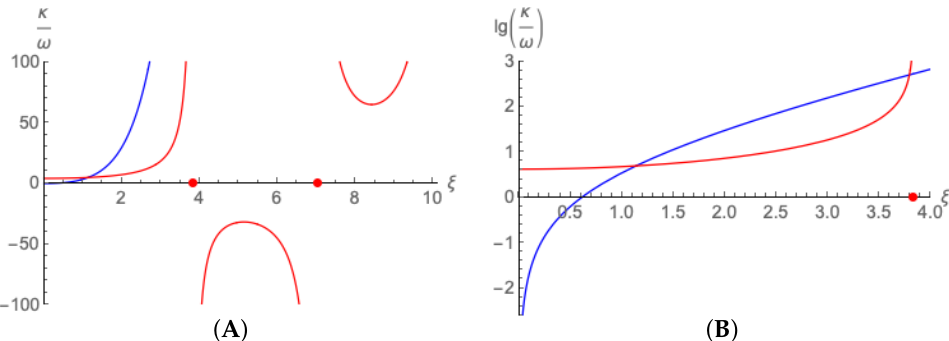
Figure 3. Model of Localized Vortices. Left pane l ( A ): Both axes are in linear scale. Right panel ( B ): Vertical axis is in log-scale. Both panels ( A,B ): A structure with three vortices forms only when √ κ / ω = ( 2 π /3 )( ξ / Z 1 ( ξ )) , where ξ = 3 ( l / R ) , l is the radius of a circumscribed circle, R = ( | α | β ) − 1/2 | ω / Ω ) | , α is the parameter characterizing the “rapidity” of increase in temperature with distance from the disk rotation axis, β = − ρ − 1 ( ∂ρ / ∂θ ) is the coefficient of thermal expansion, ω is the angular velocity of rotation of the vortex structure, Ω is the angular velocity of rotation of the accretion disk, and κ is the characteristic intensity of one localized vortex. The blue curve is for α > 0 (the disk periphery is hotter). The red curve is for α < 0 (the disk periphery is cooler): intensity √ κ → ∞ as ξ ≡ 3 ( l / R ) → ξ N (red dot) at which the Bessel function J 1 ( ξ N ) = 0. (Here ξ 1 (cid:39)